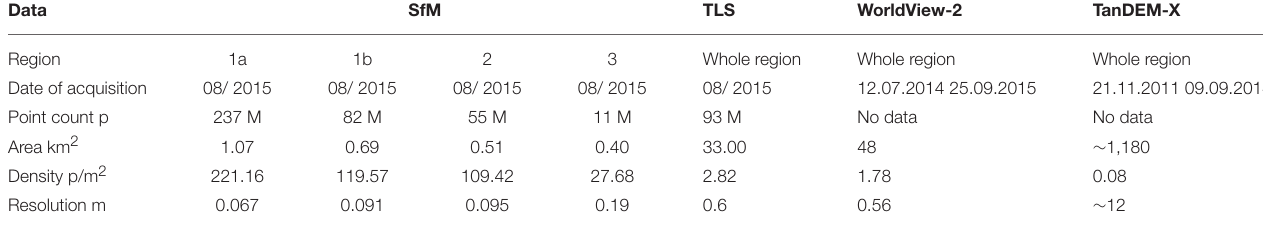
TABLE 1 | Data comparison for different areas using the methods described in the text. Data